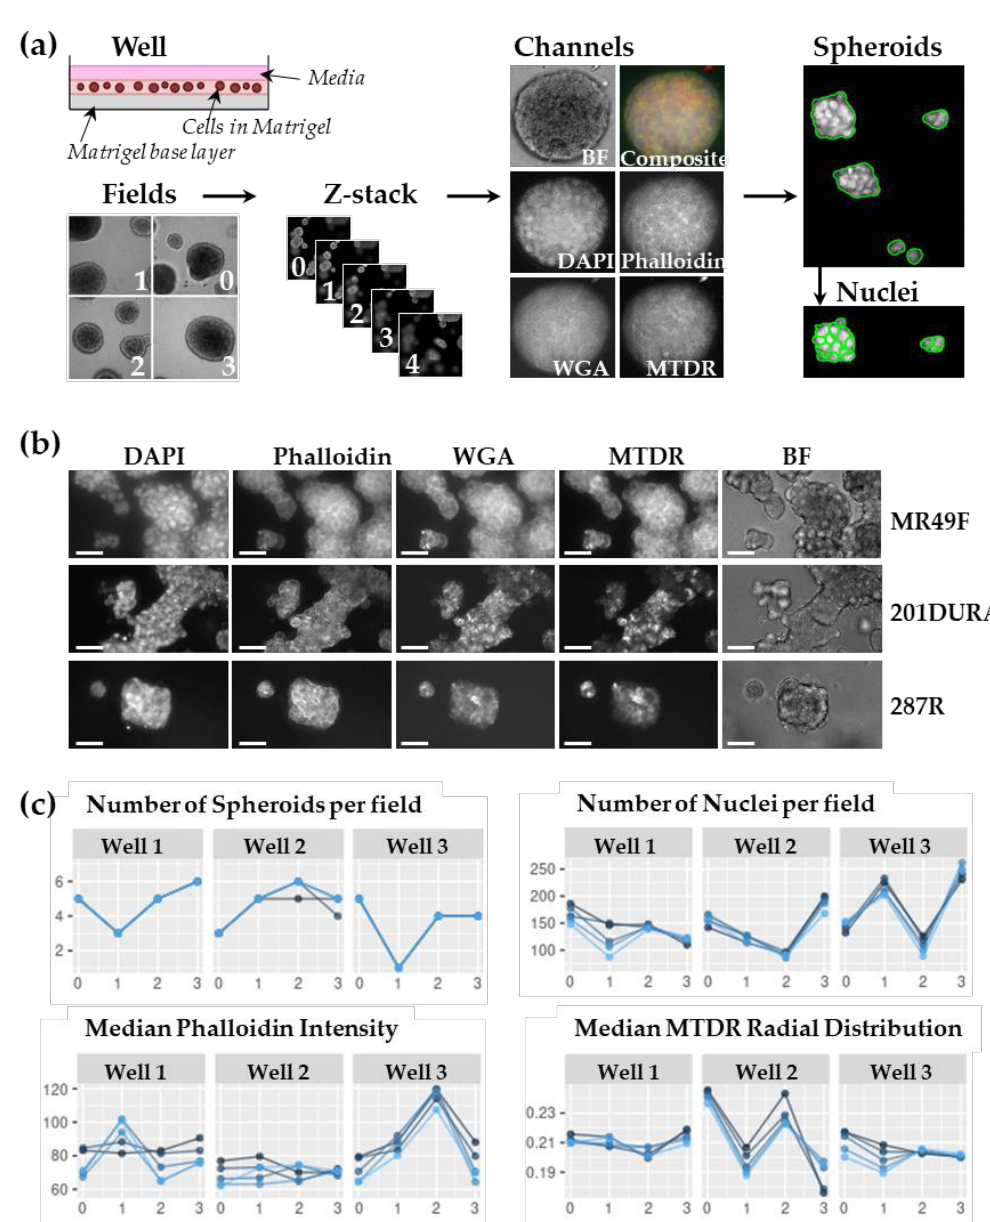
Figure 4. ( a ) Schematic overview of image acquisition of spheroids grown in a diluted Matrigel layer on top of a high concentration Matrigel base layer. Four fields/wells (labelled 0, 1, 2, 3) captured on CX7 LZR (20×) across five z-slices (labelled 0, 1, 2, 3, 4) and across five channels. Segmentation for data extraction is based on both spheroids and single nuclei in each spheroid. ( b ) Representative images of untreated prostate cancer cells grown in Matrigel captured on CX7 LZR (20×) across five z-slices and across five channels: MR49F is a cell line; 201DURA and 287R are organoids from patient-derived prostate cancer xenograft models. ( c ) Selection of Nuclei- or Spheroid-based imaging features in three vehicle-treated control wells across all captured fields and z-slices. Different shades of blue of circles and lines correspond to results extracted from five z-heights.